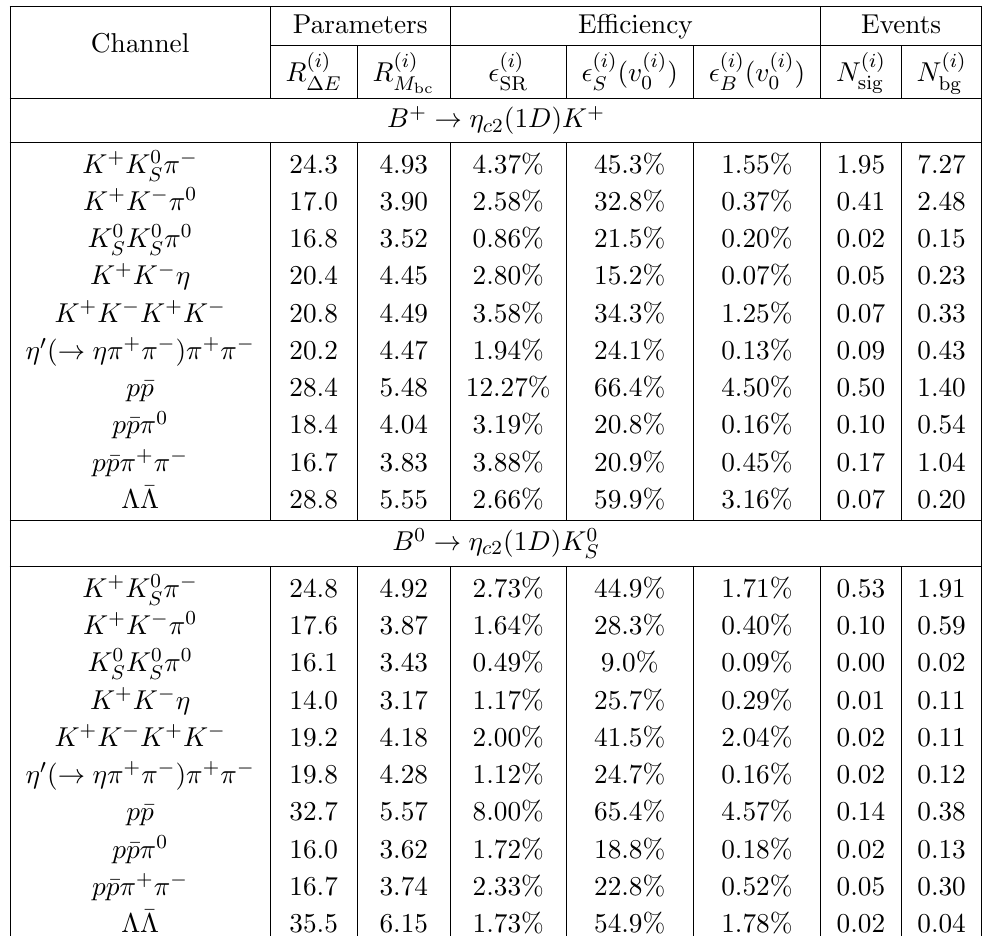
( R ( i ) ) (cid:1) E M bc